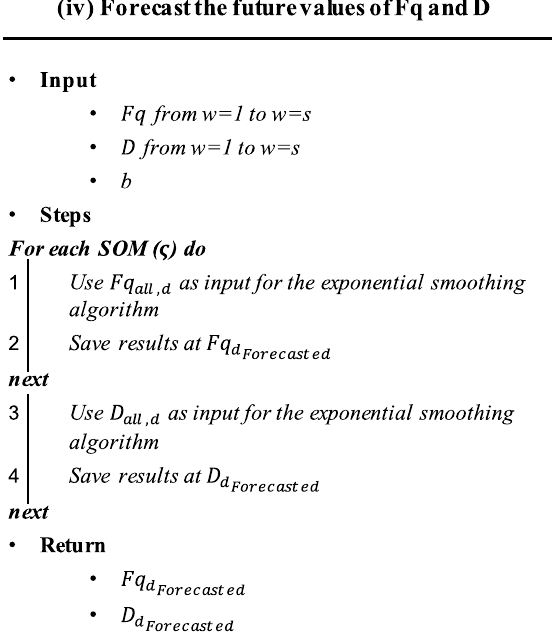
Figure 5. Pseudo-algorithm of step iv.